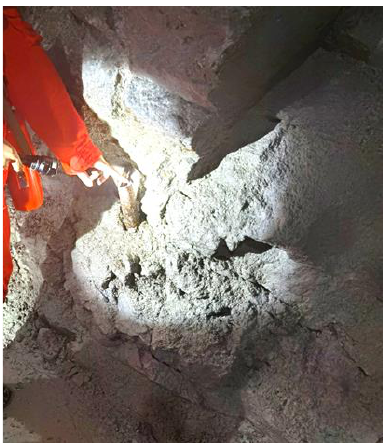
Figure 2. The layered subsidence problem was observed from the adjacent mine